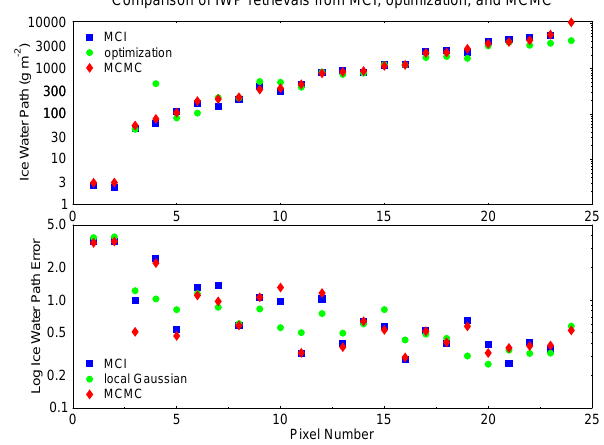
Fig. 14. Ice water path retrieved using Monte Carlo integration, op- timization, and Markov chain Monte Carlo (top panel) for 24 se- lected pixels (sorted in order of MCMC IWP). ln (IWP) error re- trieved using MCI, local Gaussian approximation, and MCMC methods (bottom panel).